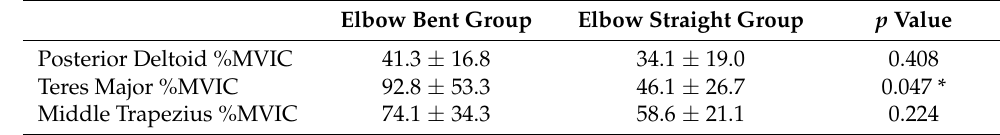
Table 7. Muscle activation in athletes with different elbow styles. Elbow Bent Group Elbow Straight Group p Value Posterior Deltoid %MVIC 41.3 ± 16.8 34.1 ± 19.0 0.408 Teres Major %MVIC 92.8 ± 53.3 46.1 ± 26.7 0.047 * Middle Trapezius %MVIC 74.1 ± 34.3 58.6 ± 21.1